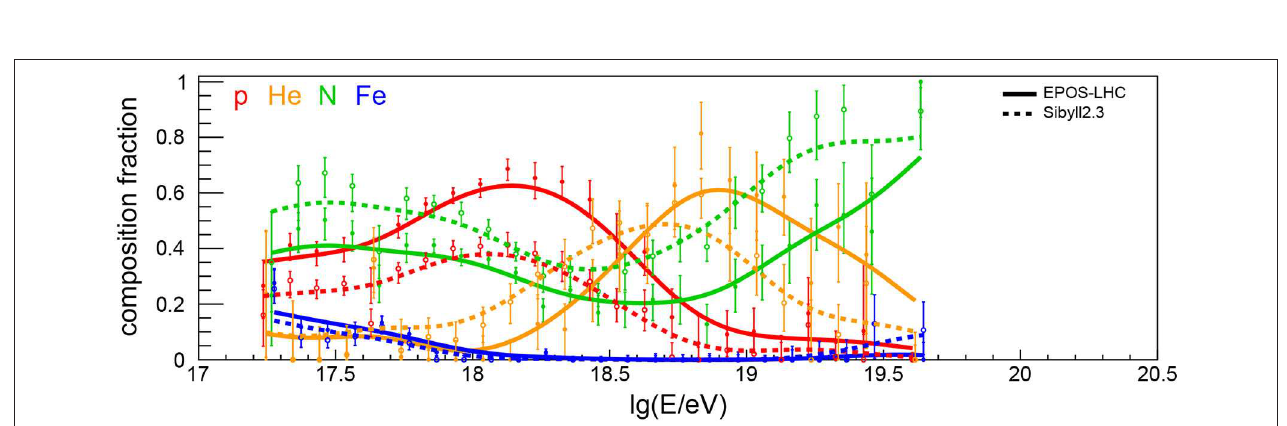
FIGURE 5 | Composition fractions arriving at Earth derived from fitting templates of four mass groups to the X max distribution measured with the fluorescence detectors of the Pierre Auger Observatory (adapted from Bellido, 2018). Error bars denote statistical uncertainties and lines were added to guide the eye. The two interpretations of the data with EPOS-LHC and Sibyll2.3 are shown as closed and open symbols with solid and dashed lines styles, respectively. The QGSJetII-04 interpretation from Bellido (2018) is not shown, since it does not give a good description of the X max distributions over a wide range in energy (see also discussion in Aab et al., 2014b). As of today, no composition fractions are available around and above 10 20 eV. M. Unger for this